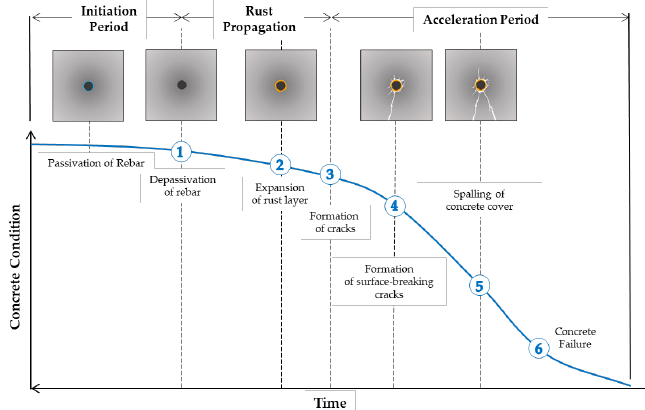
Figure 1. Conceptual illustration of deterioration process of steel corrosion in concrete.